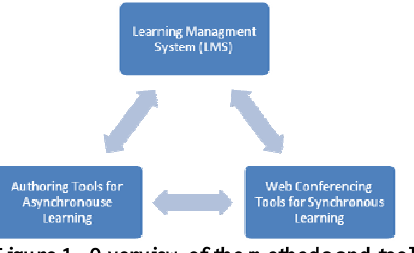
Figure 1. Overview of the methods and tools